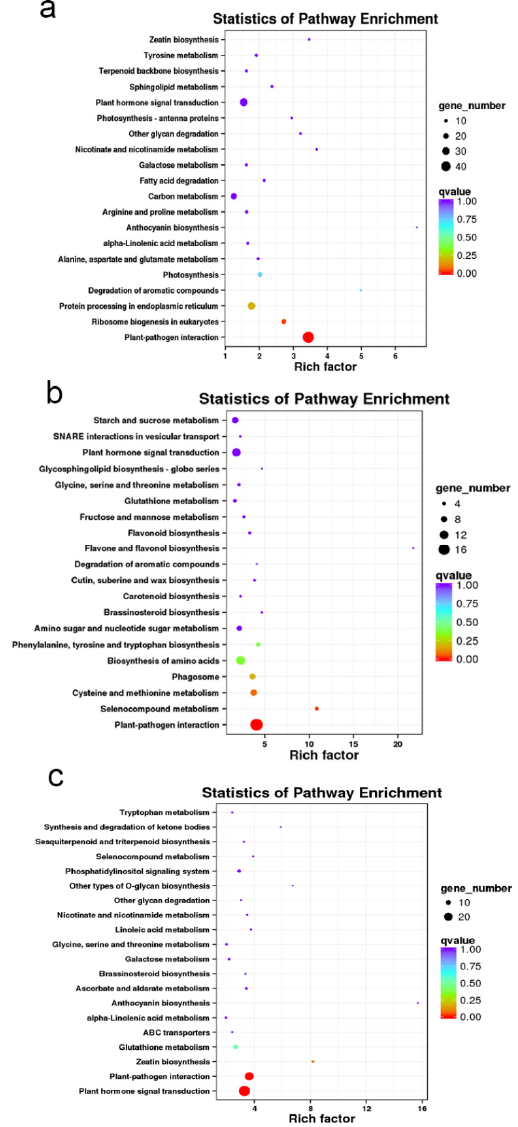
Figure 7. KEGG enrichment on the DEGs among CK, T12, and F20 under salt stress treatment. ( a ) KEGG enrichment of the DEGs between T01, T02, T03 and T10, T11, T12 samples; ( b ) KEGG enrichment of the DEGs between T04, T05, T06 and T13, T14, T15 samples; ( c ) KEGG enrichment of the DEGs between T07, T08, T09 and T16, T17, T18 samples .